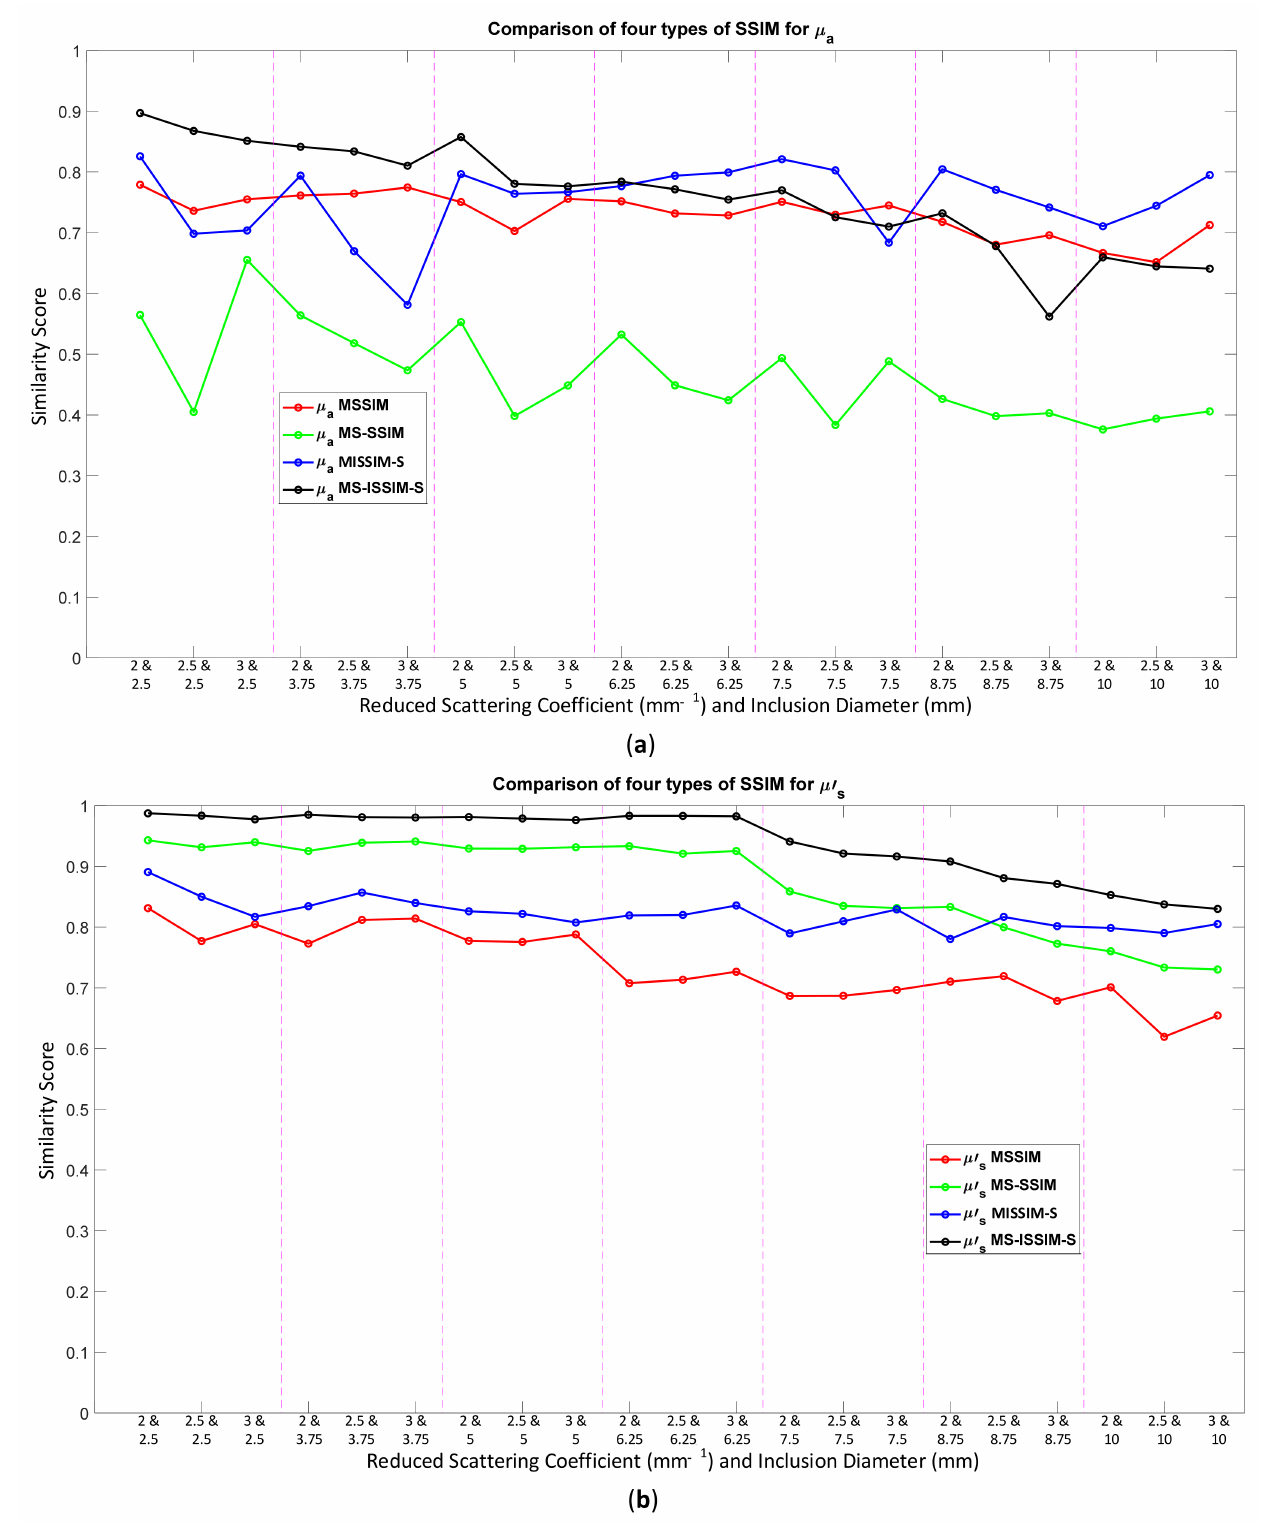
Figure 14. Four types of SSIM similarity score of case B1 with 10% noise amplitude, phase, and optical properties for ( a ) µ a and ( b ) µ (cid:48) s